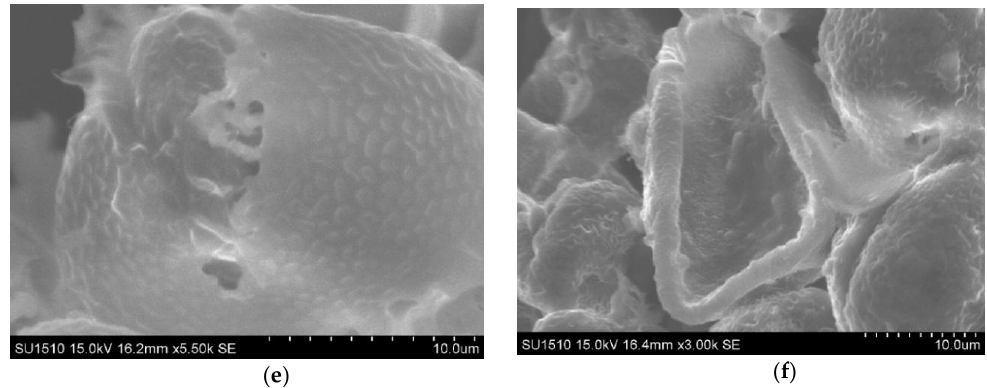
Figure 7. SEM evaluation of the ultrastructure of mono-floral, apple pollen, which has a more uniform shape. ( a ) unfermented pollen; ( b ) 1-day fermented pollen, with attached bacteria (arrow); ( c , d ) 7 days fermented pollen; ( e ) detail: pollen granule cracked after 10 days of the fermentation process; ( f ) detail: pollen granule drained because of the10 day of fermentation process.